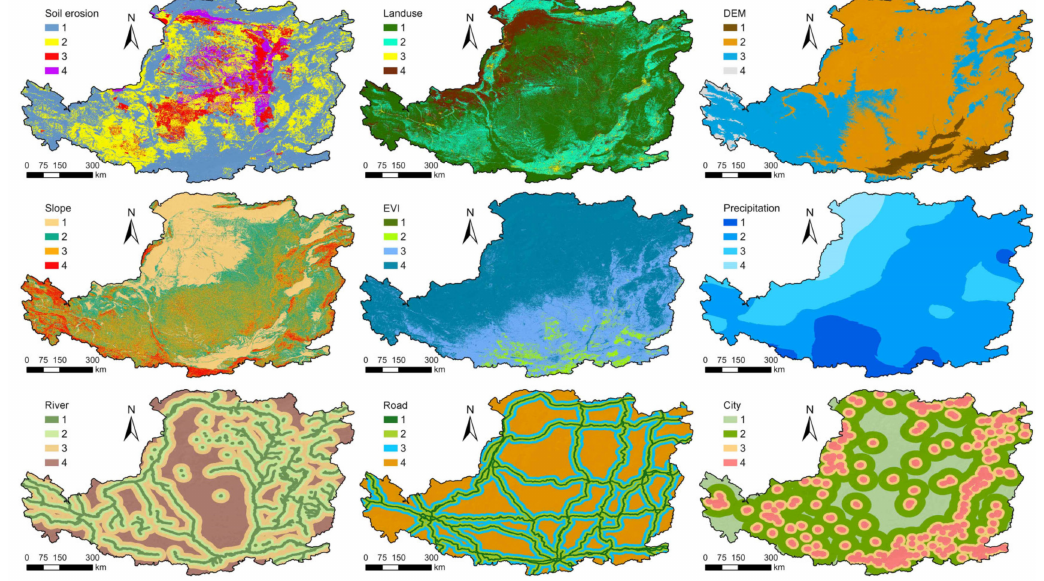
Figure 5. Resistance factors of the MCR